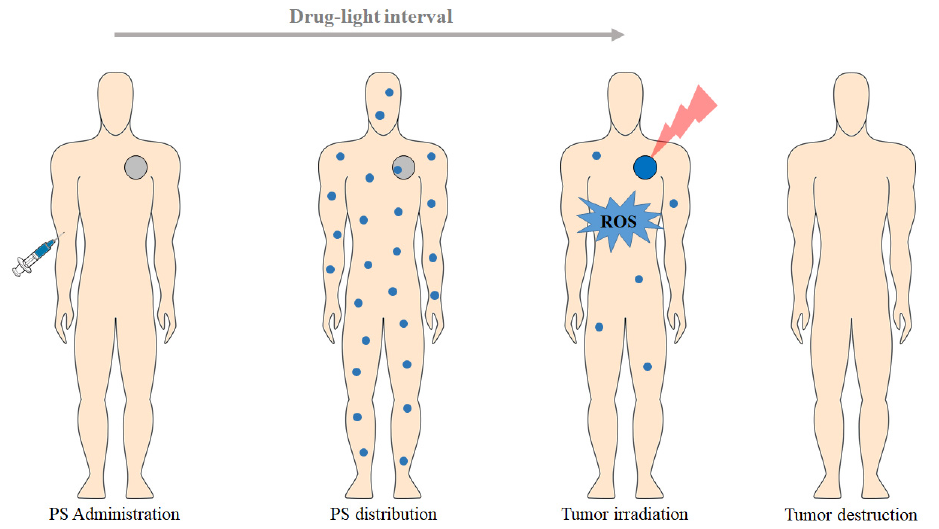
Figure 1. Representation of the clinical application of PDT protocol for the treatment of a solid and localized tumor (based on [12]).